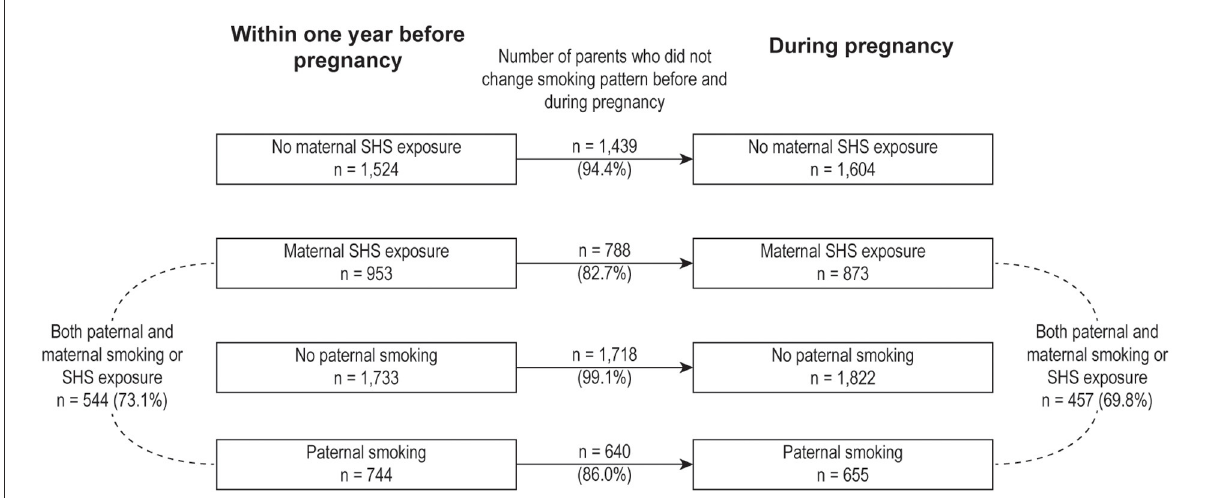
FIGURE1 Parental smoking exposure pattern before and during pregnancy. The black lines represent the number of fathers or mothers who kept the same smoking or second-hand smoke exposure (or did not be exposed to smoking) patterns before and during pregnancy. The black dashed lines represent the number of both parents who were exposed to smoking or second-hand smoke. SHS, second-hand